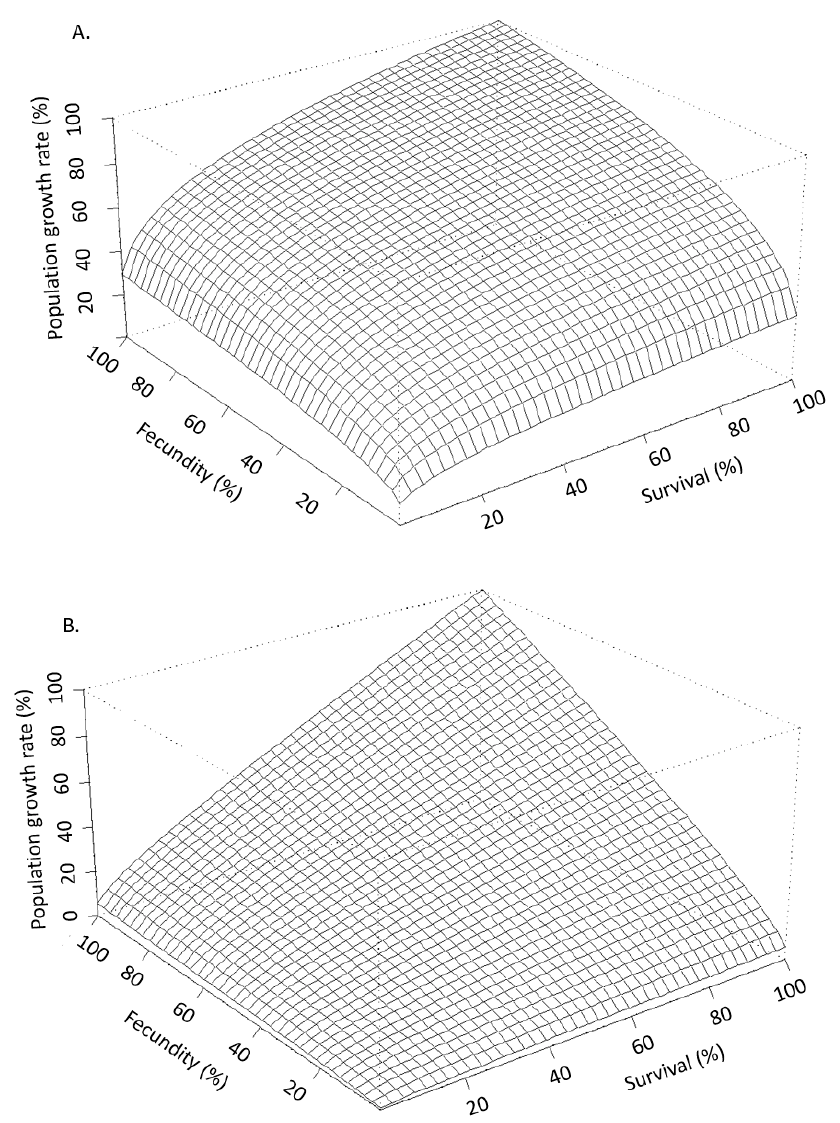
Figure 2. Stress response curves in 3-dimensions for hypothetical species exhibiting classical ( A ) “K-strategist” and ( B ) “r-strategist” life-history types (from Raimondo et al., [33], reprinted with permission).